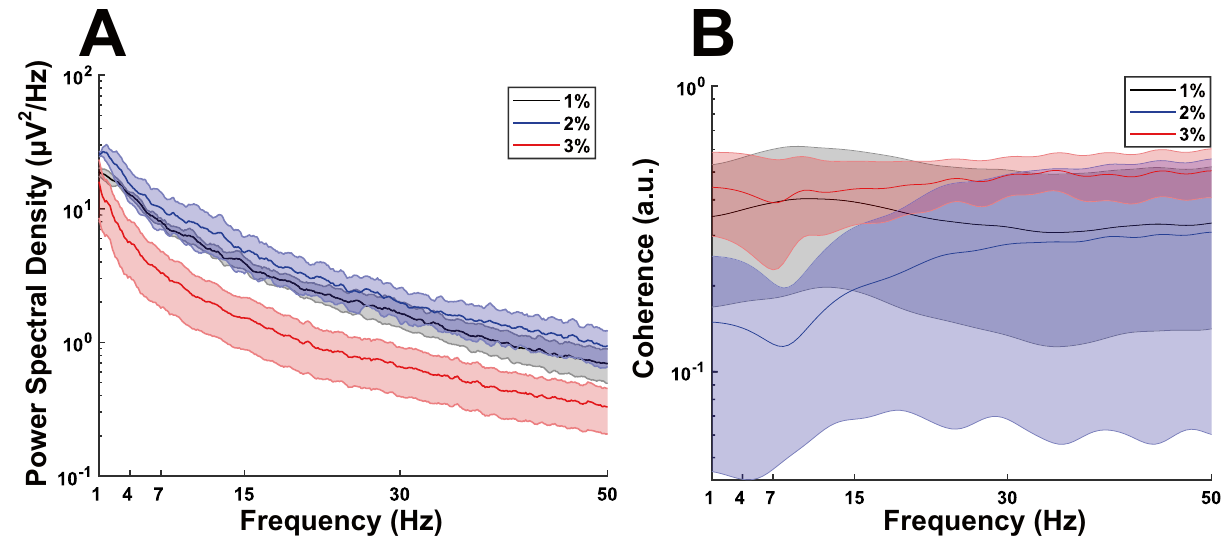
Figure 6. Neurophysiological effects of isoflurane. Dose dependent and reversible anesthetic effect of isoflurane general anesthesia on the ECoG. ( A ) Mean and standard error of the power spectral density recorded under 2% isoflurane (black spectra with error lines), 3% isoflurane (red spectra with error lines) and re-adjusted 2% isoflurane (blue spectra with error lines). ( B ) Coherence under 2% isoflurane (black spectra with error lines), 3% isoflurane (red spectra with error lines) and re-adjusted 2% isoflurane (blue spectra with error